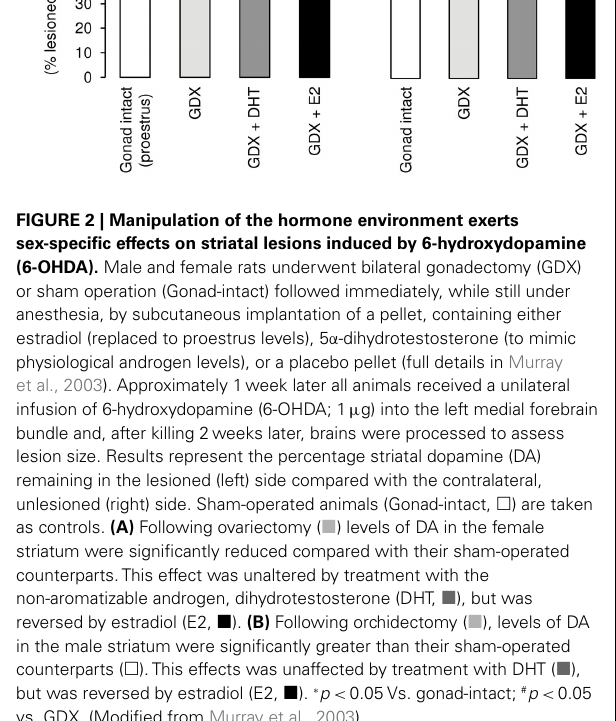
Table 1 | Sex differences in experimental PD.